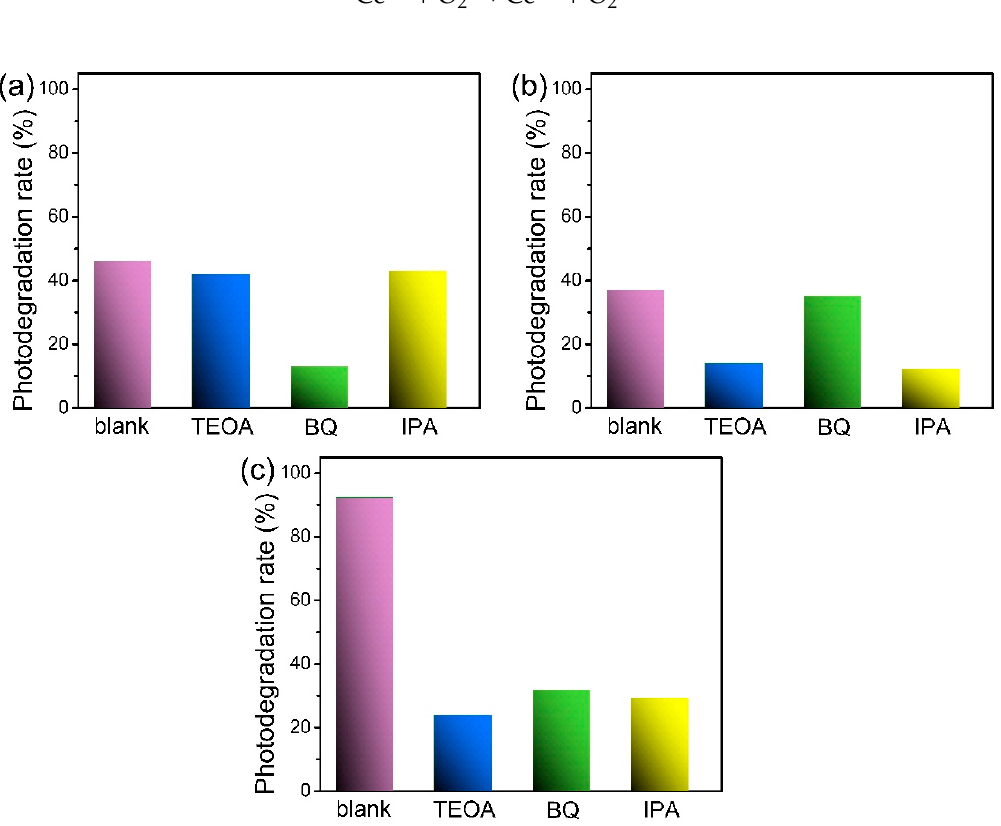
Figure 14. Determination of active species in degradation of TC by ( a ) Ag 2 Se, ( b ) CeO 2 QDs, and ( c ) 10% CeO 2 QDs/Ag 2 Se.